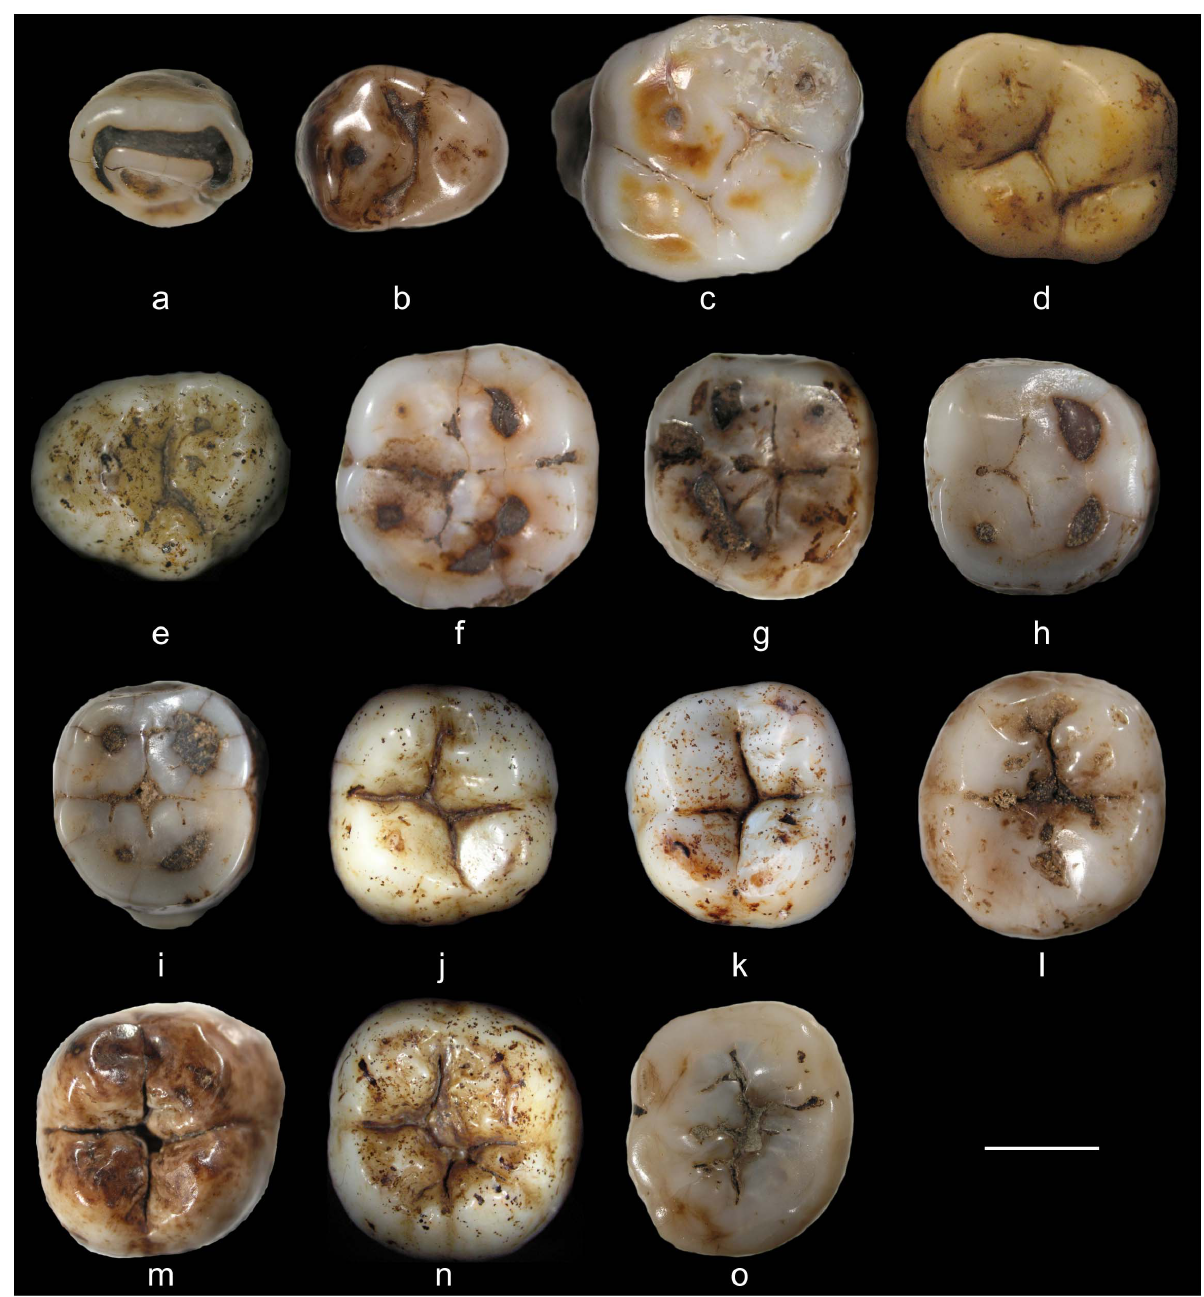
Figure 2. The fifteen permanent crowns forming the new Javanese fossil human dental sample from the Sangiran Dome in occlusal view. : a, MI92.2; b, NG9505; c, NG91-G10 n u 1; d, PDS0712; e, NG0802.1; f, MI92.1; g, NG92.2; h, NG92.1; i, NG92.4; j, NG0802.3; k, PCG09_KII_Z:1.37; l, NG92.3, m, NG92 D6 ZE 57 s/d 76; n, NG0802.2; o, NG9107.2. Scale is 5 mm. doi:10.1371/journal.pone.0067233.g002 complete, while the oblique crest is thicker and incised by the view, is high, even if moderately worn (stage 3), with smoothed central groove. The Fm is erased by the wear, but the triangular lingual cusps, slightly more elevated buccal cusps, and two small Fc and the narrow Fd are still perceptible. In the lateral view, the dentine spots on the Pa and Pr. Four main cusps are visible with Pr . Pa . Hy =Me. On the lingual aspect of the Pr, a slight mesial and distal crown faces diverge occlusally, the lingual aspect is bulging and the buccal face slopes towards the cervix. A large, protuberance indicates the presence of a Carabelli cusp, but, ovoid and flat ICF is located on the occlusobuccal quarter of the due to the occlusal wear, its size and morphology cannot be mesial aspect. The distal ICF, also large, ovoid and flat, is situated scored. The Mmr, despite being affected by occlusal wear, is thick in the middle of the distal aspect. The light brown root fragment and complete, while the Dmr, still high, is thick and slightly shows two buccal roots and one lingual, the two former broken incised. The transverse crest is not very elevated, thick or